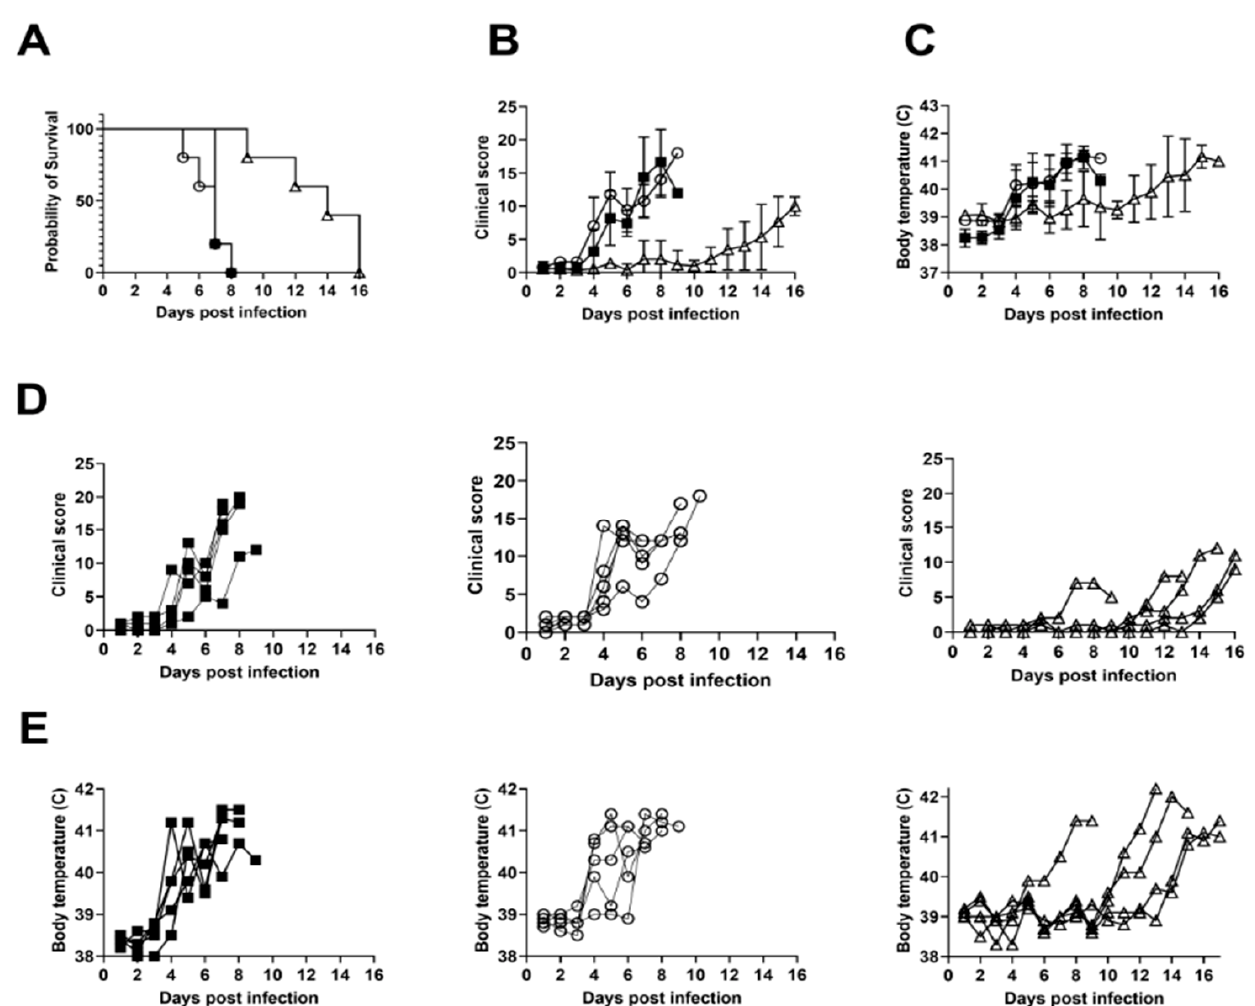
Figure 2. Clinical data from pigs inoculated with WSL-grown and macrophage-grown viruses. ( A ) The survival, ( B ) mean clinical scores, and ( C ) mean body temperatures after inoculation with 10 2 TCID 50 of WSL grown virus ( ▪ ), 10 2 HAD 50 blood macrophage grown virus ( ○ ), or 1 HAD 50 blood macrophage grown virus ( ∆ ). ( D ) Individual clinical scoring data and ( E ) body temperatures for the different animals in the different groups.